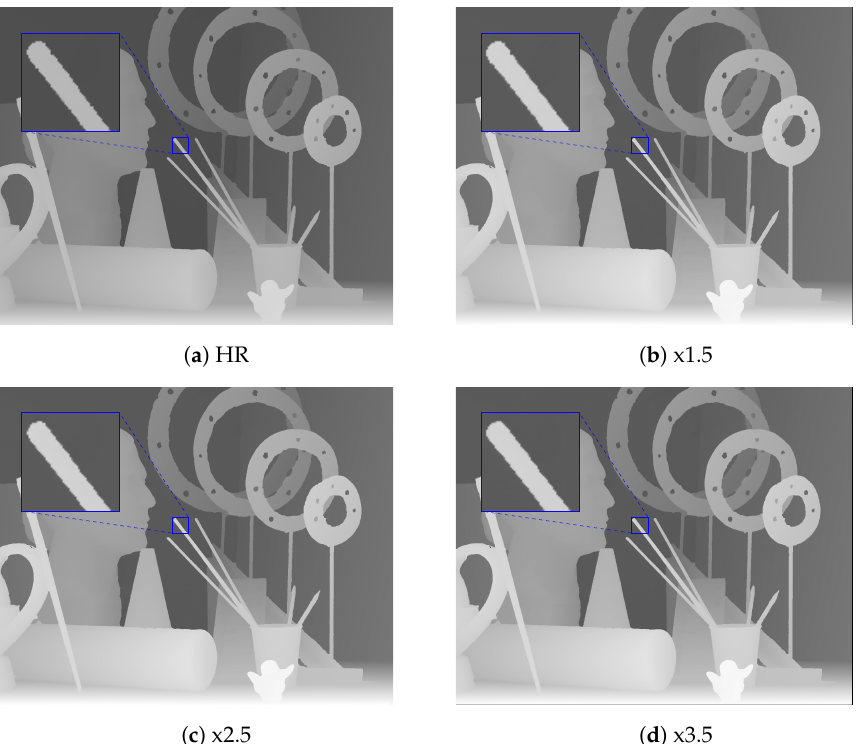
Figure 6. Visual comparison of DSR for the proposed method on the Art depth map with different scale